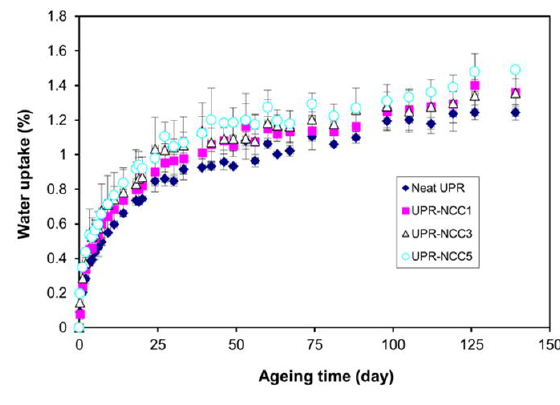
Fig. 1. (a) Specimens of water absorption, tensile and impact tests (not to scale), (b) tensile testing.